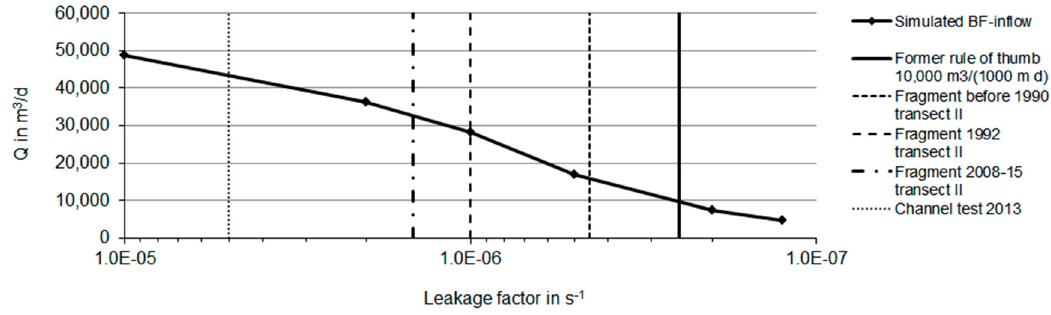
Figure 8. Theoretically recoverable share of bank filtrate for a 1000 ‐ m ‐ long river stretch during low ‐ flow based on a groundwater flow modeling for WW Dresden–Tolkewitz.